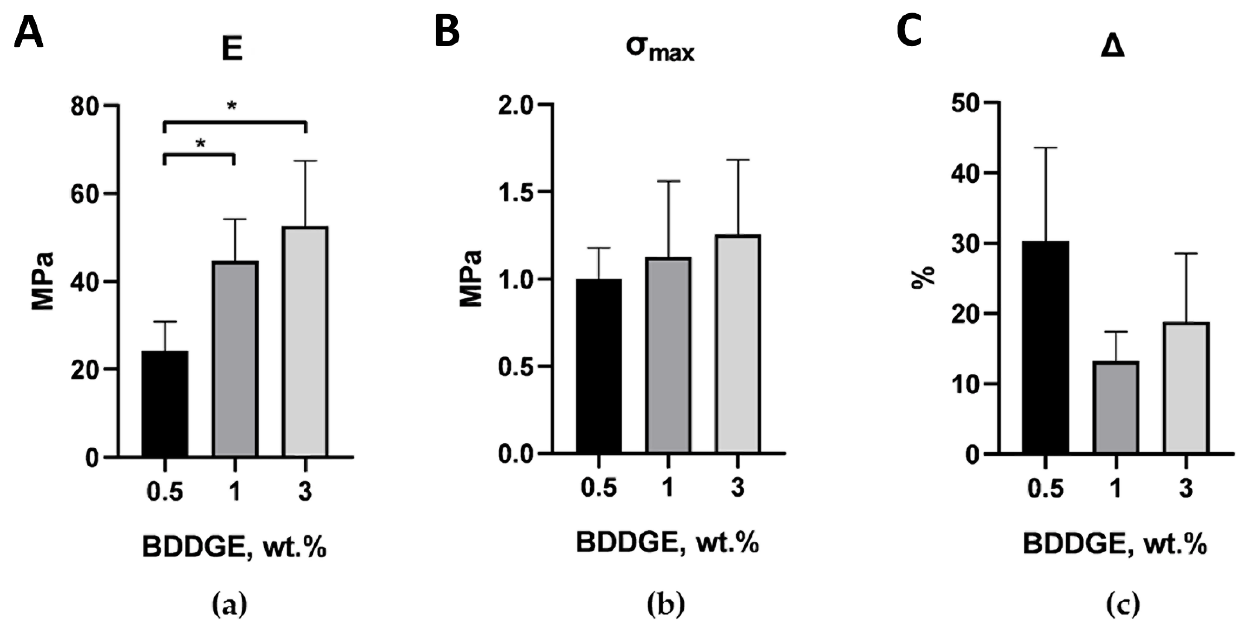
Figure 3. Tensile test results for dry ELS COL samples immersed in isopropanol with 15 wt.% BDDGE for 6 days, dried and immersed in PBS for 1 day: ( а ) Young’s modulus, ( b ) tensile strength, ( c ) maximum elongation. * p < 0.05, ** p < 0.01 in Student ’ s t-test; data are the mean ± SD of at least 3 replicates.